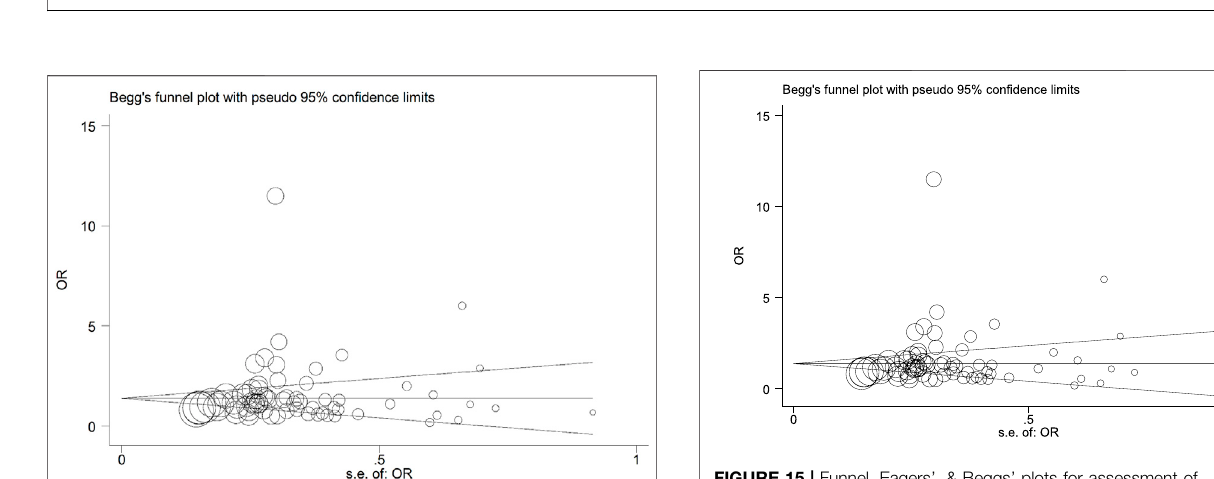
FIGURE 13 | Forest plot: ORsubgroup analysis for Urokinase, by SNP subgroup.